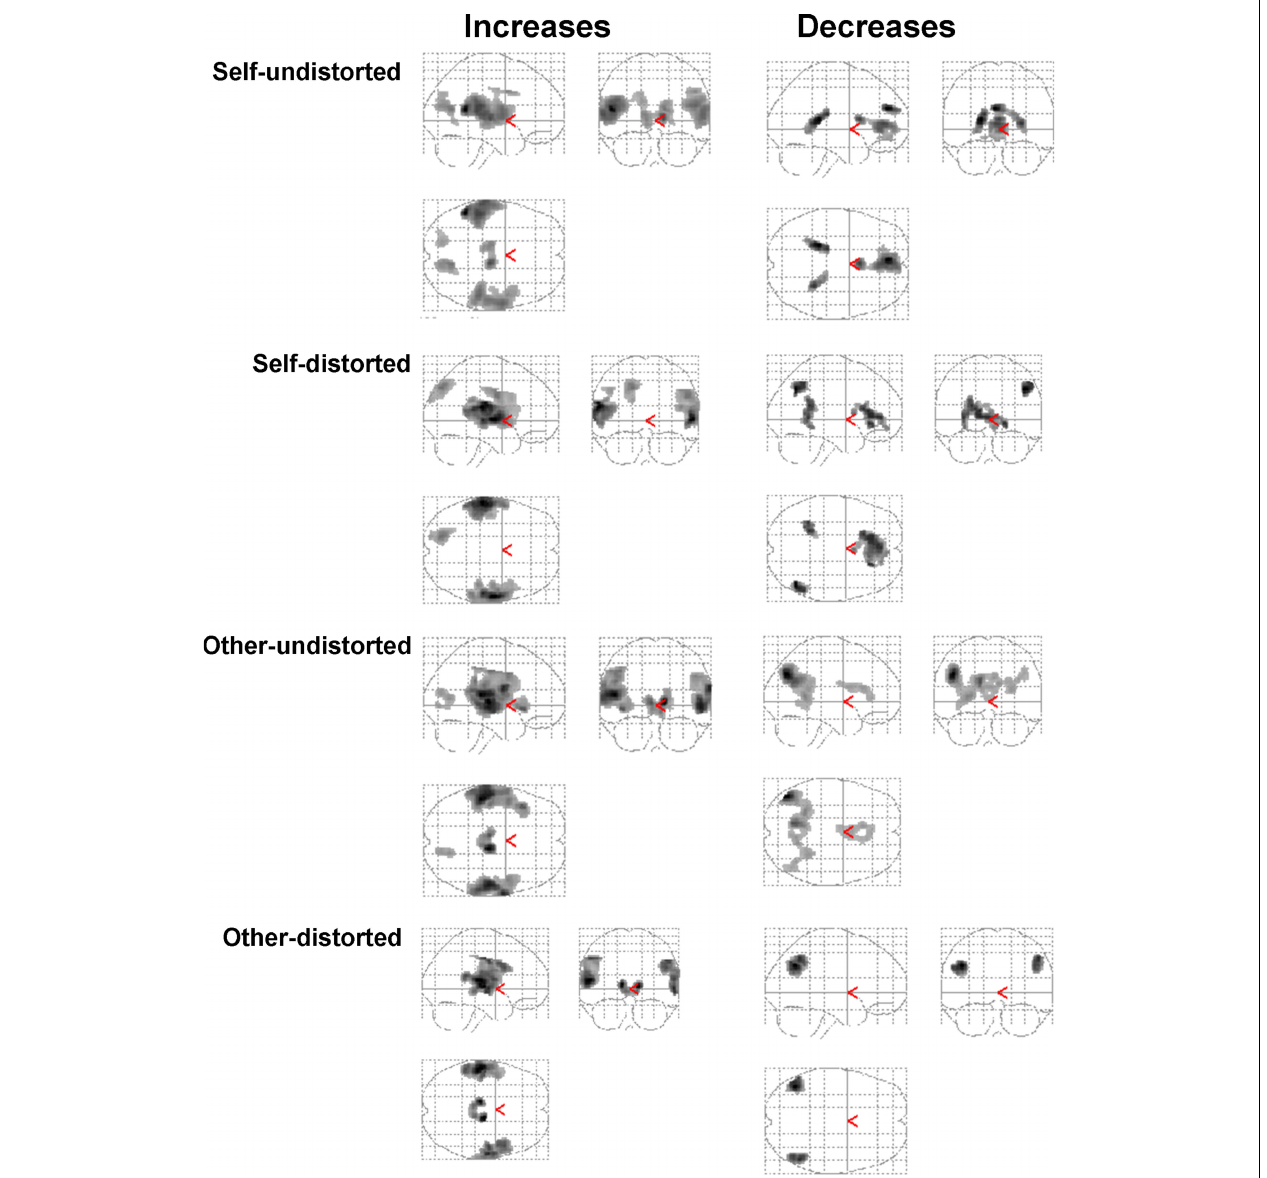
FIGURE 1 | Group activation maps showing regions with signifi cant task- related activity changes in CBTp + TAU patients in the sagittal, coronal and axial “look through” views (maps thresholded at ρ = 0.001